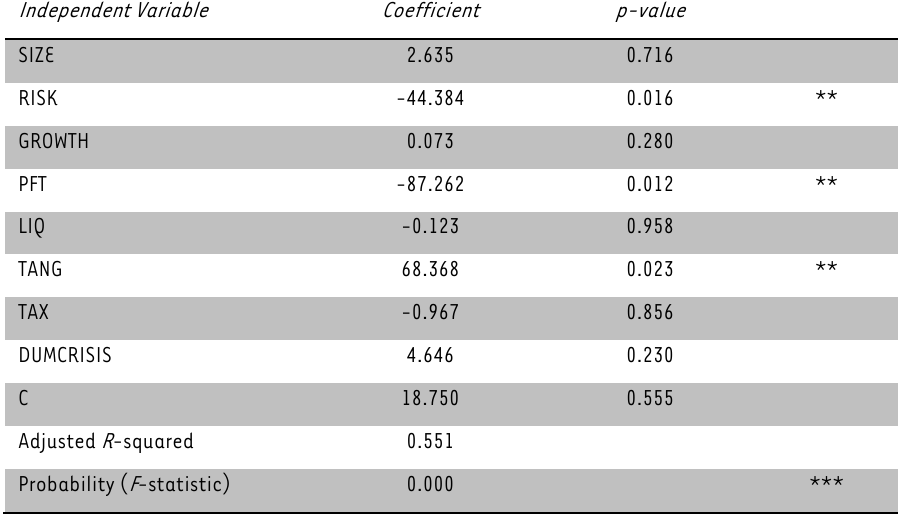
TABLE 3: Fixed effects cross-sectional model results of the relationship between independent variables and capital